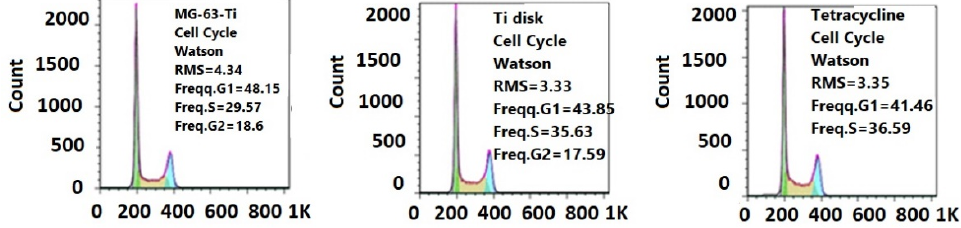
Figure 13. Flow cytometry diagrams of cellular cycle of MG63 cells grown on a standard plastic substrate (left), Ti control disk (center), and deposited composite film (right).